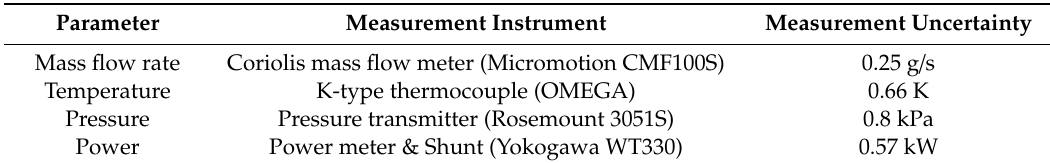
Table 1. Measurement instrument with each